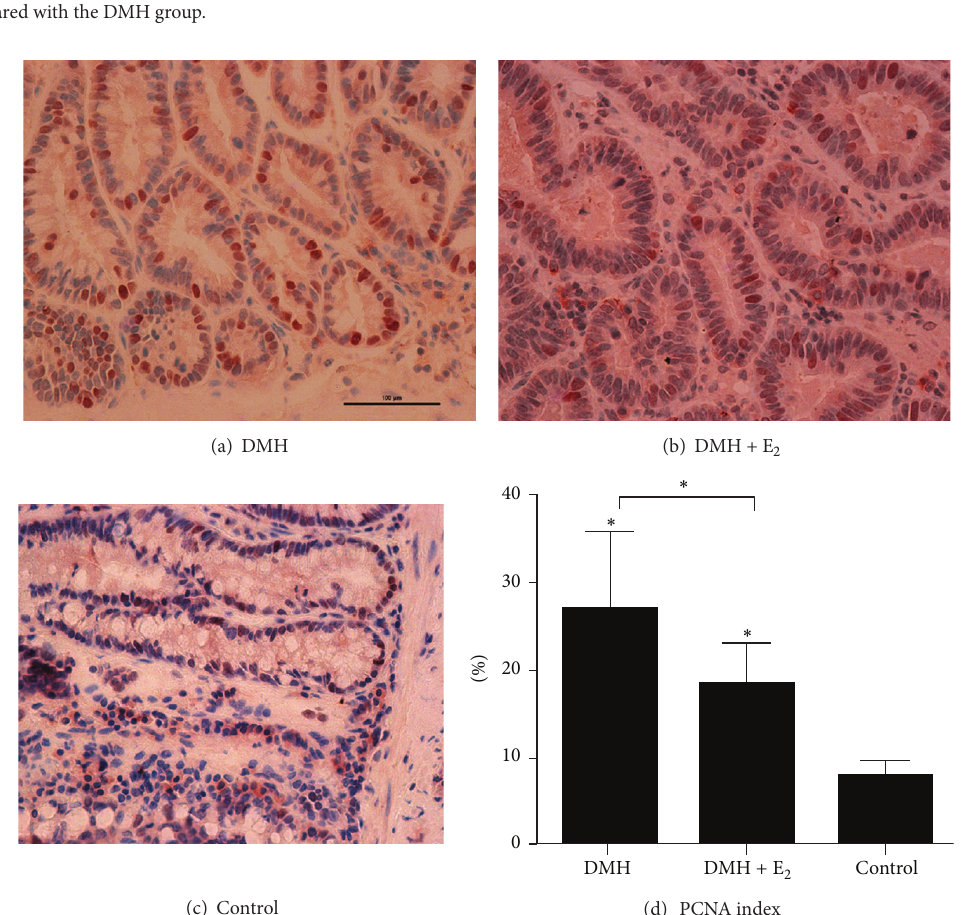
Figure 2: PCNA expression in each group. (a) PCNA staining in polyp from the DMH group. (b) PCNA staining in polyp from the DMH + E 2 group. (c) PCNA staining in normal colonic mucosa from the control group. (d) Comparison of PCNA index in different groups ( ∗ 𝑃 < 0.05